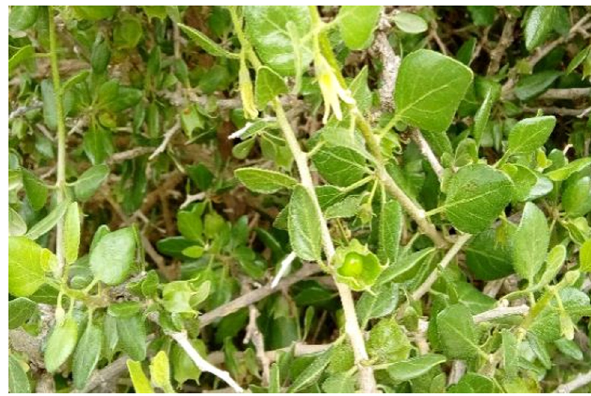
Figure 1: The biological form of the plant Withania frutescens